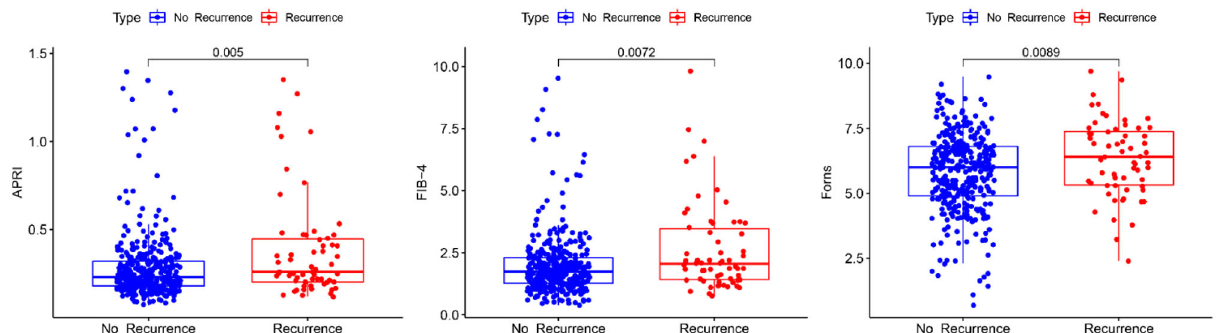
addition of APRI into the CM allowed a significant incremental prediction of risk for CSDH recurrence ( p < 0.05, when